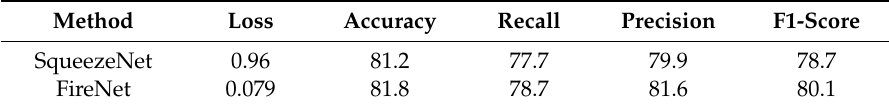
Table 1. Results of the proposed FireNet method and